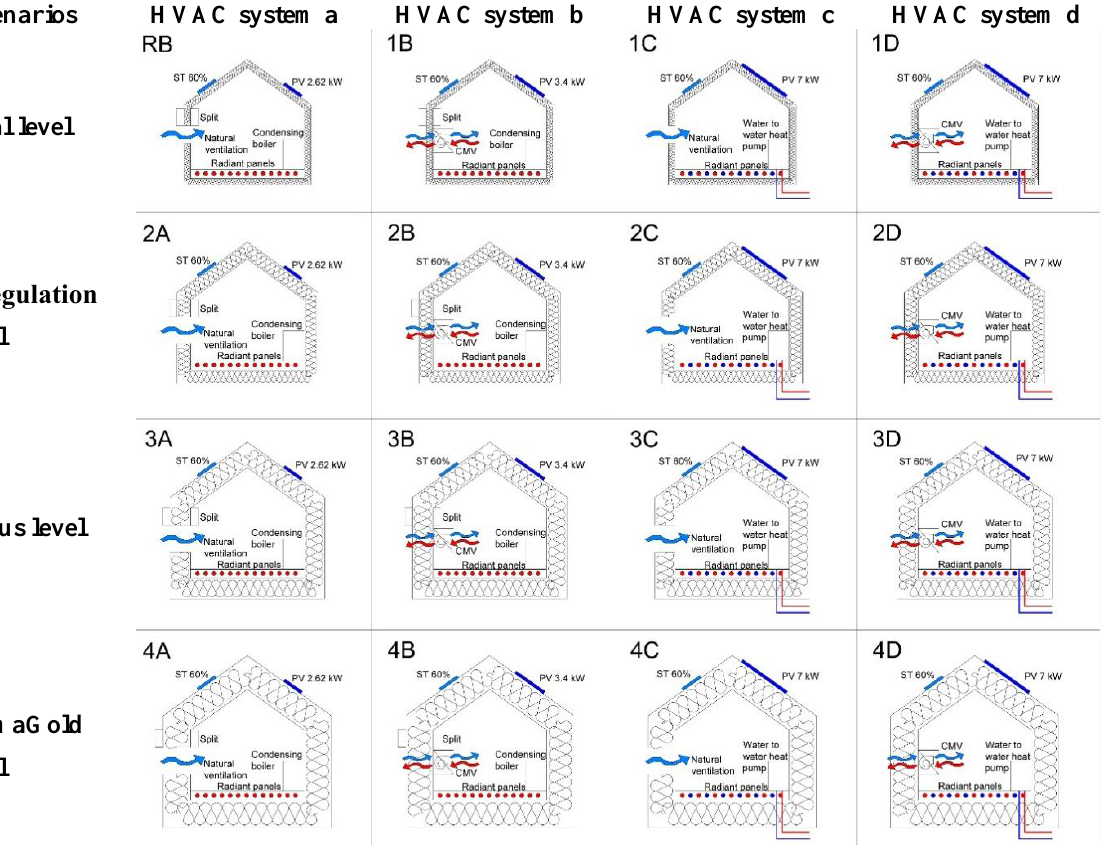
Figure 5. Matrix of the 16 energy design